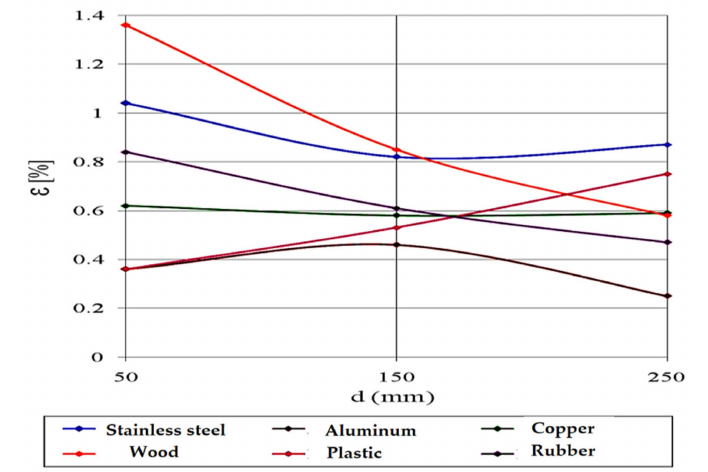
Figure 20. Relative error variation for different materials.